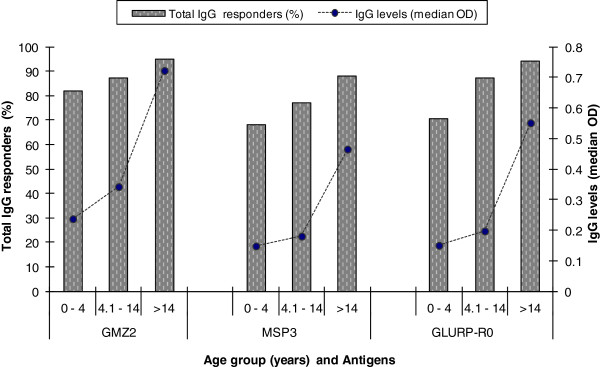
The positivity and levels of total IgG antibodies to P. falciparum, GLURP-R0, MSP3 and GMZ2 in subjects of different ages from Boditi. The bars represent the proportion of total IgG responders and the broken line with filled circles represent levels (median OD) of the response.